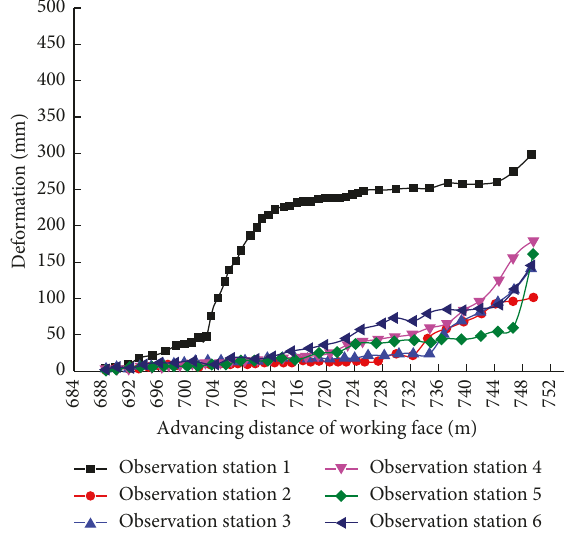
Figure 16: Roof-to-floor convergence of the main retracement